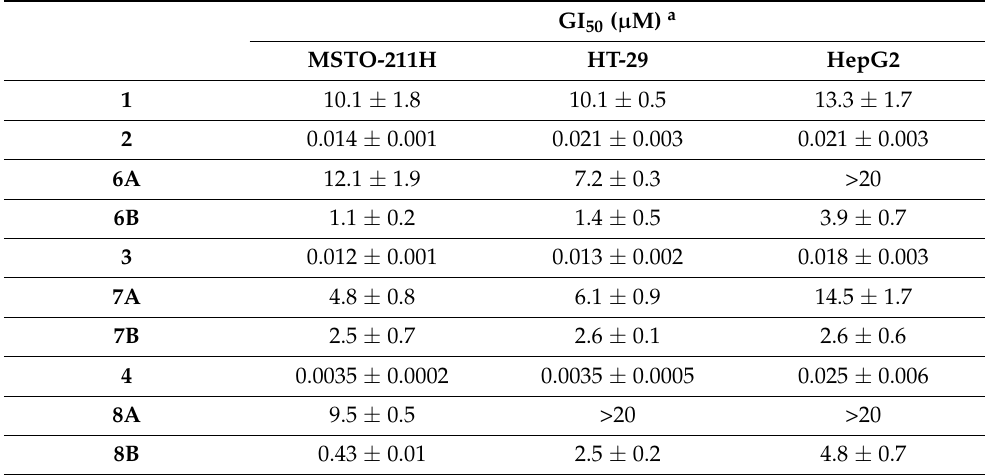
Table 2. Antiproliferative effect of NPs and the corresponding reference drugs, CBD ( 1 ), N -desacetyl thiocolchicine ( 2 ), podophyllotoxin ( 3 ), and paclitaxel ( 4